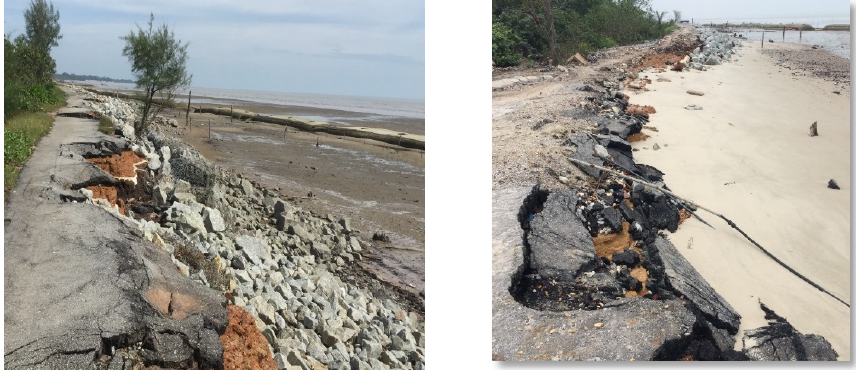
Figure 1. Example of coastal hazard showing erosion in Kelanang Beach, Selangor, Malaysia.